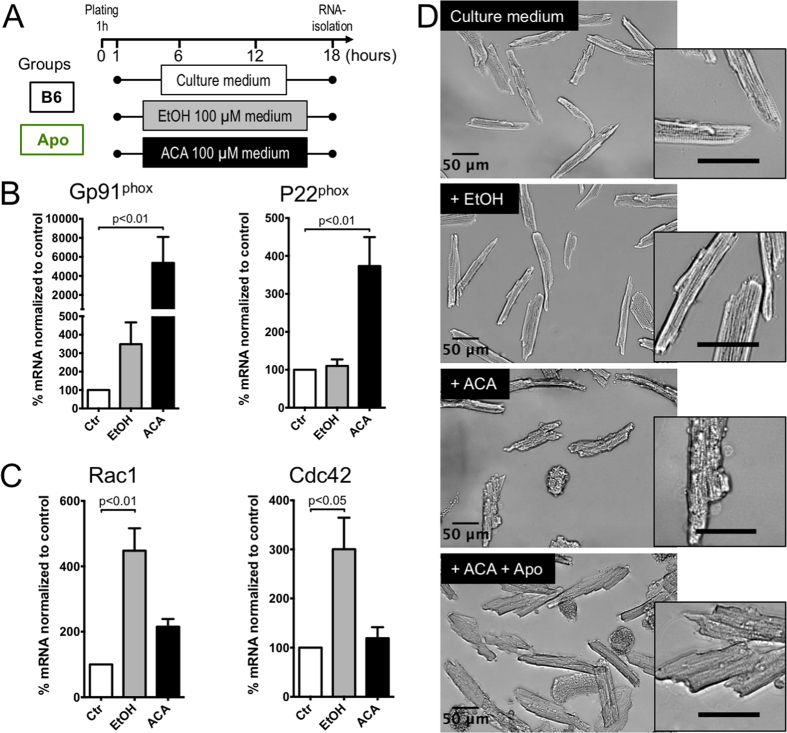
Exposure of isolated CMs to EtOH or ACA induces upregulation of NOX.(A) Scheme depicting incubation of isolated adult CMs with EtOH (100 μM) or ACA (100 μM). (B) Expression of NOX2 subunit gp91phox and p22phox. (C) Expression of Rac GTPase Rac1 and of the Rho-family GTP binding protein cell division cycle 42 (CDC42). (D) Brightfield images of live mouse adult CMs after incubation in media supplemented with EtOH or ACA with or without apocynin, the scale bars were kept at 50 μM. (B,C) Data presented as the mean ± SEM.